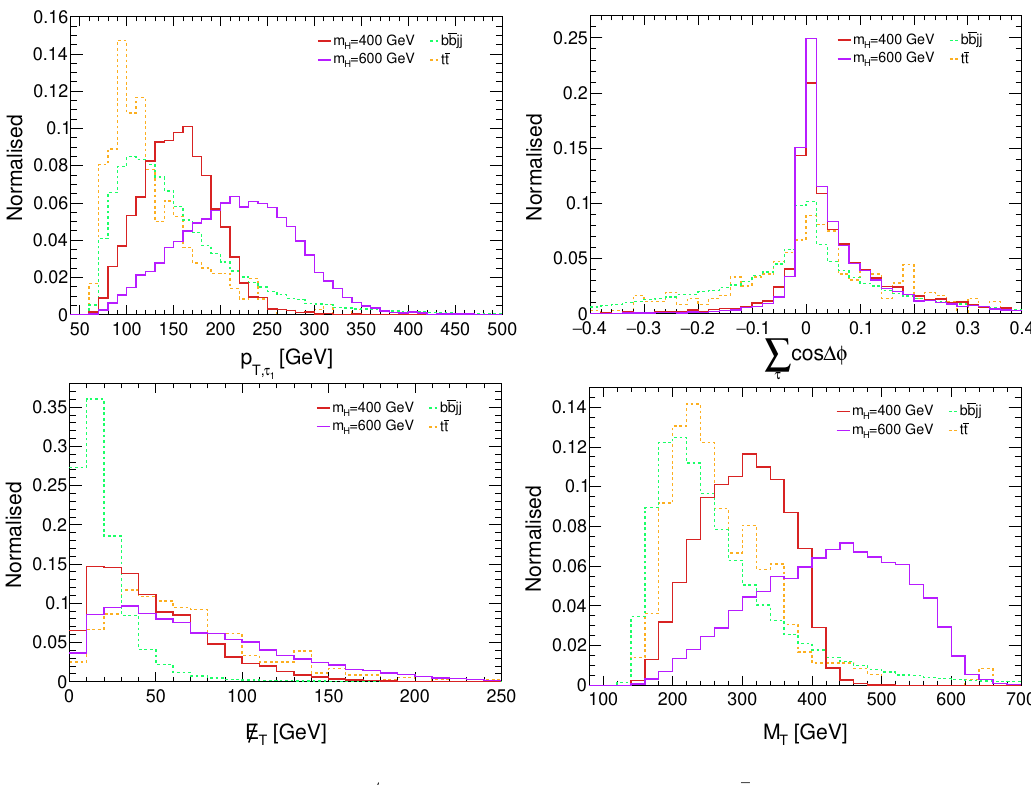
Figure 36 . The p T;(cid:28) , P cos (cid:1) (cid:30) , =E T and M T distributions for the b (cid:22) b(cid:28) h (cid:28) h category for m H = 400 1 (cid:28) 1 ; 2 and 600 GeV with dominant backgrounds. Here the heavy Higgs boson is searched for in the b (cid:22) bH channel. The distributions are shown before the optimisation